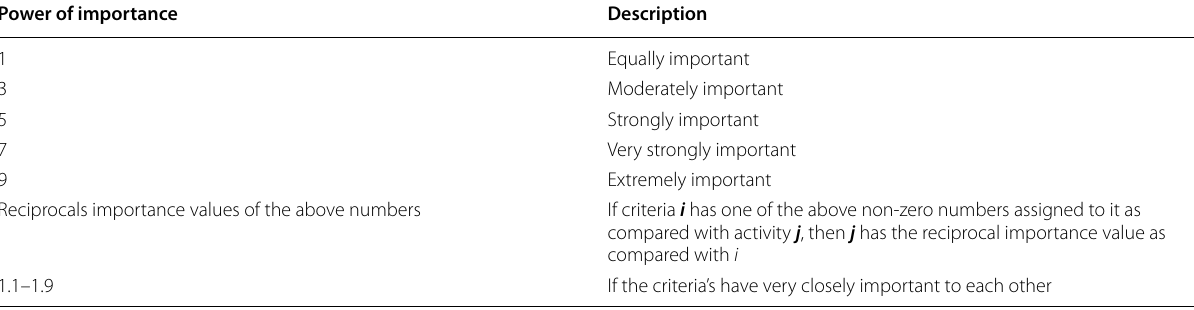
Table 2 Important scale of relative importance of numbers in AHP (Saaty 2008) Power of